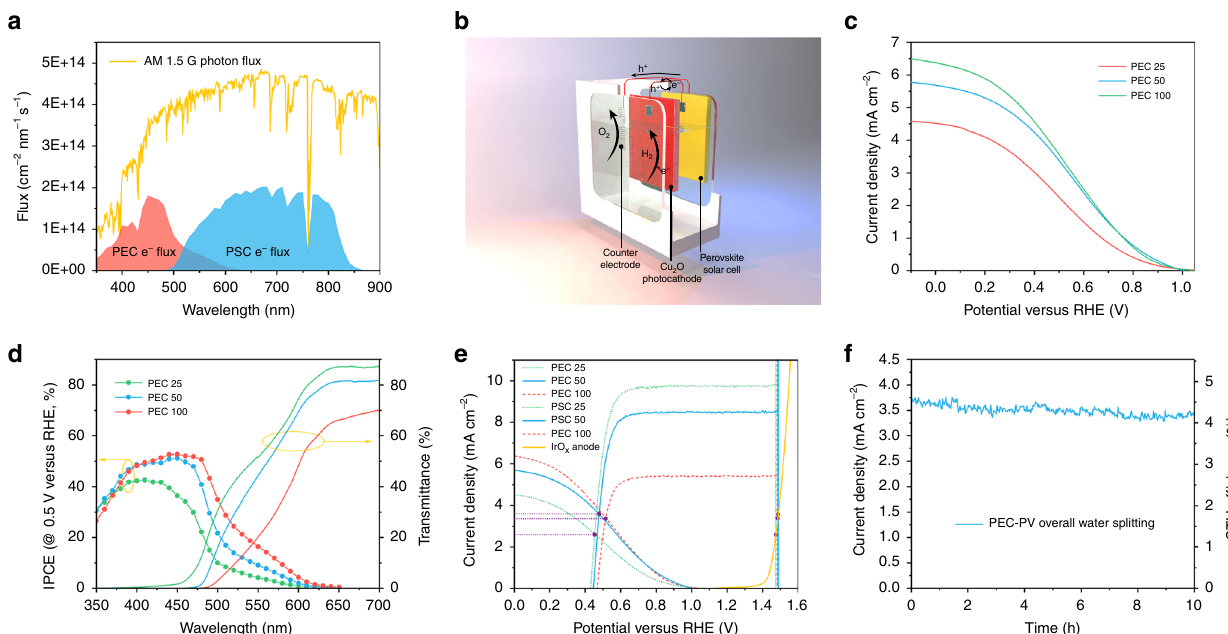
Fig. 4 Standalone solar water splitting. a Plot of photon fl ux based on AM 1.5 G spectrum and expected electron fl uxes of photocathode and PV calculated from wavelength-dependent IPCE responses of photocathode at 0.5 V versus RHE and PV at short circuit. b Illustration of PEC-PV tandem con fi guration based on CuSCN-incorporated Cu 2 O photocathode, PSC and IrO x anode. c J – E responses of transparent Cu 2 O photocathodes with various thicknesses. Numbers in sample names denote the electrodeposition duration of Cu 2 O in minutes. d Wavelength-dependent IPCE of transparent Cu 2 O photocathodes biased at 0.5 V versus RHE and corresponding transmittance spectra. e Estimated tandem operating current density by overlaying J – E curves of photocathodes, J – V curves of PV cells and linear-sweep voltammetry of IrO x anode. f Chronoamperometry of assembled PEC-PV tandem tested under simulated one-sun illumination in pH 5 buffered electrolyte with zero